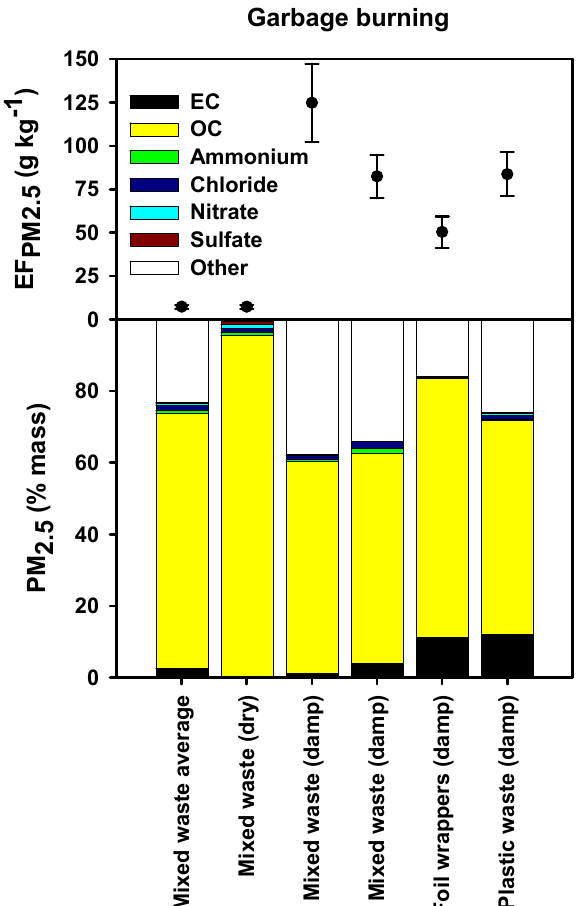
Figure 2. EF PM and PM 2 . 5 composition (as percent by mass) for 2 . 5 garbage burning. EF PM for the combustion of mixed waste under 2 . 5 dry conditions was substantially lower than mixed waste burned un- der damp conditions. The former was considered the best estimate of EF PM emissions from this source and is shown as the mixed- 2 . 5 waste average EF PM along with the average PM 2 . 5 composition 2 . 5 (% mass) for the three mixed waste burns. Error bars correspond to analytical